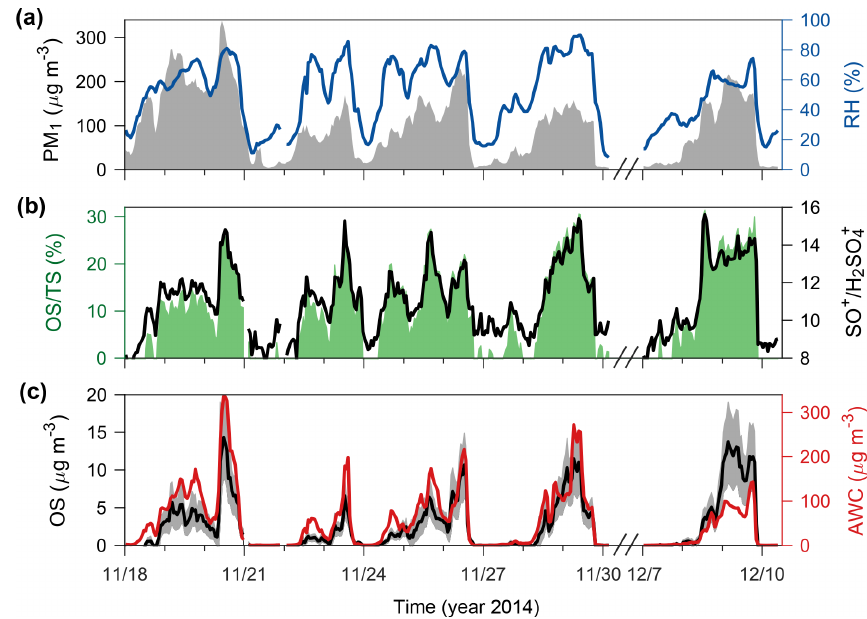
Figure 2. Possible presence of OS in Beijing winter haze aerosols. (a) PM 1 concentrations (left, gray-shaded area) and RH (right, blue line). (b) Contributions of OS to TS (left, green-shaded area) and ratios of SO + to H 2 SO + (right, black line). The ratios between the other 4 inorganic sulfur-containing ions are given in Fig. S3. (c) Sulfate-equivalent OS concentrations (left, black line) and AWC (right, red line). The gray-shaded area in (c) indicates the 1 σ uncertainty range of OS concentrations (on average ∼ 40% during haze